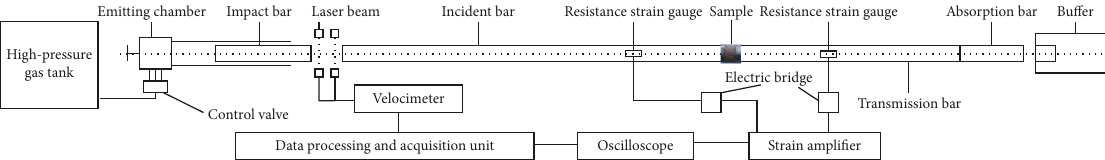
Figure 3: Hopkinson pressure bar system.